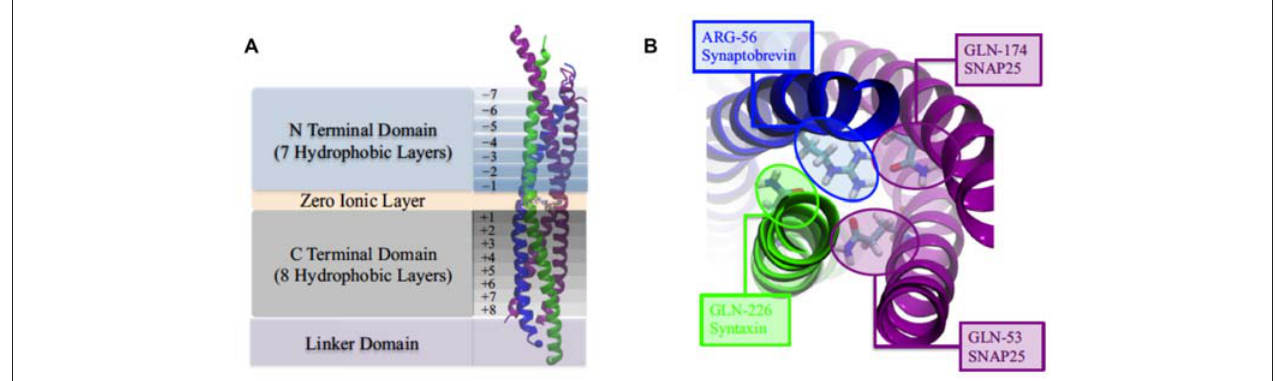
FIGURE 3 | (A) The four domains of neuronal SNARE protein: N Terminal Domian, Zero Ionic Layer, C Terminal Domain, Linker Domain; and involved four helices: snaptobrevin (blue), syntaxin (green), synaptosome-associated protein with relative molecular mass 25 K (SNAP25; magenta). (B) Top view of zero ionic layer. Reproduced with permission from Tekpinar and Zheng (2014).